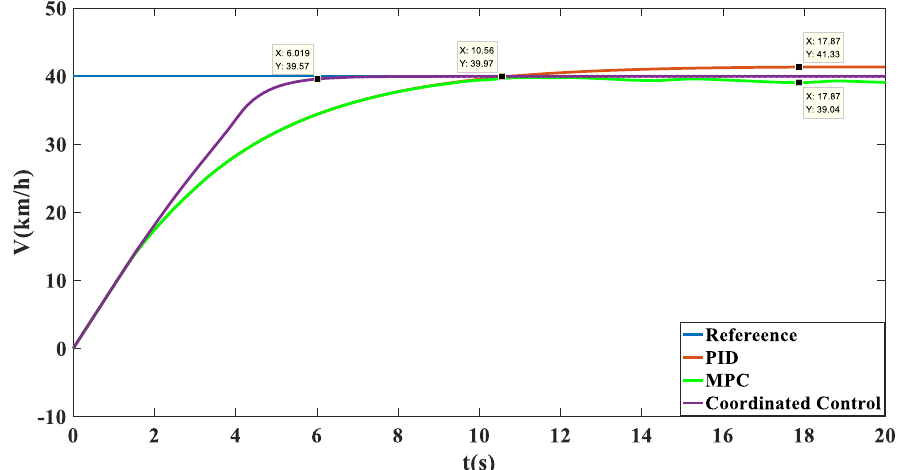
Figure 10. Speed tracking comparison chart on the split mu straight road.